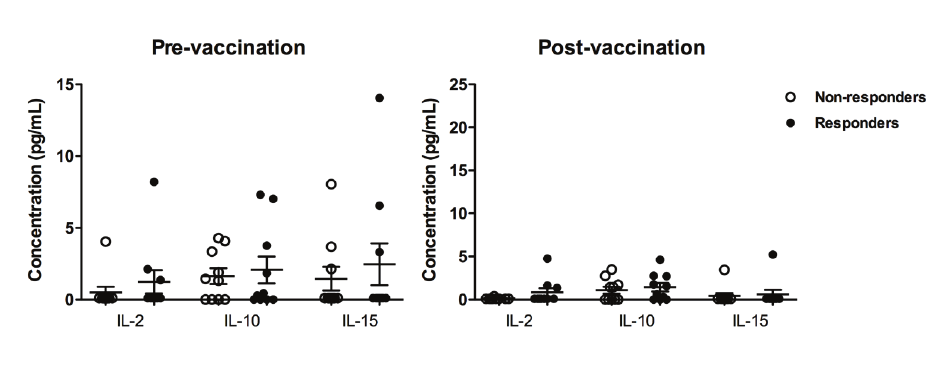
Supplementary Figure 1. Scatterplot comparison of additional cytokines (IL-2, IL-10, and IL-15) for HBV responders compared to